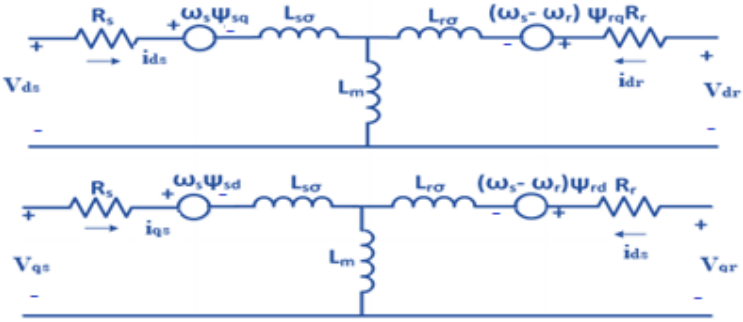
Figure 5. DFIG equivalent circuit in dq synchronous reference frame.